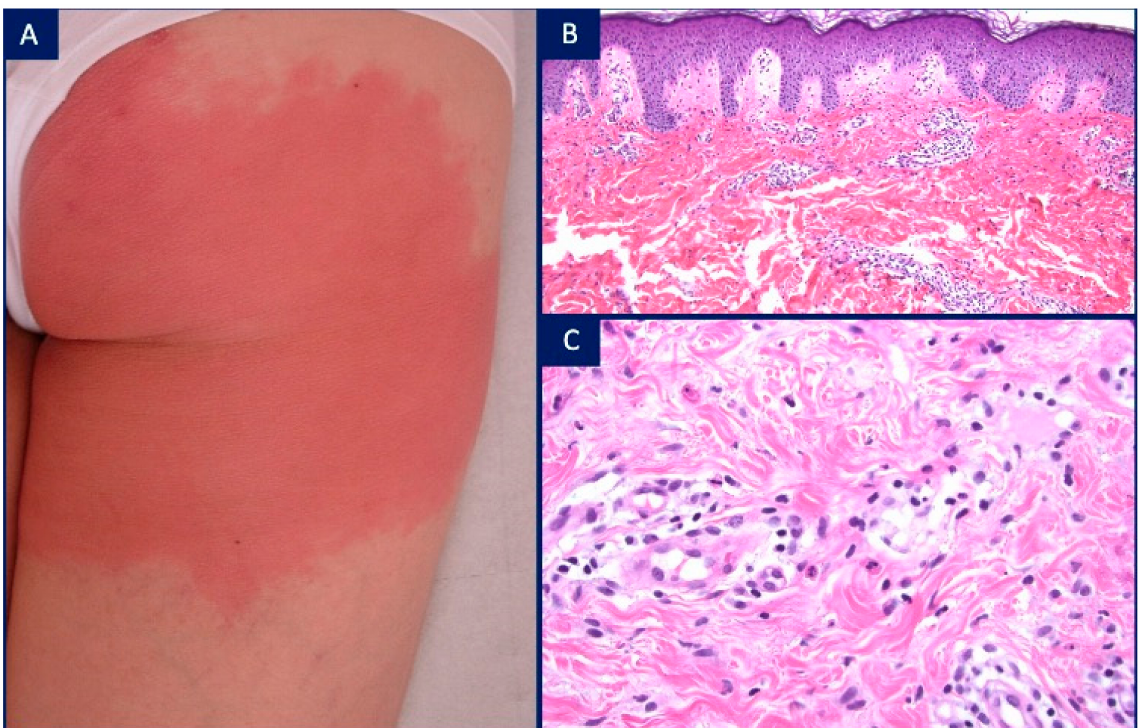
Figure 4. Erysipelas-like erythema in familial Mediterranean fever syndrome (FMF): ( A ) 34-year-old female with a recurrent, well-demarcated erythematous plaque on the right buttock, spontaneously resolving within 2–3 days; ( B ) H&E, × 4. Mild papillary dermal edema, dilated blood and lymphatic vessels surrounded by a mild inflammatory cell infiltrate; ( C ) H&E, × 20. Perivascular infiltrate of lymphocytes and neutrophils with slightly thickened vessel walls, but devoid of fibrin